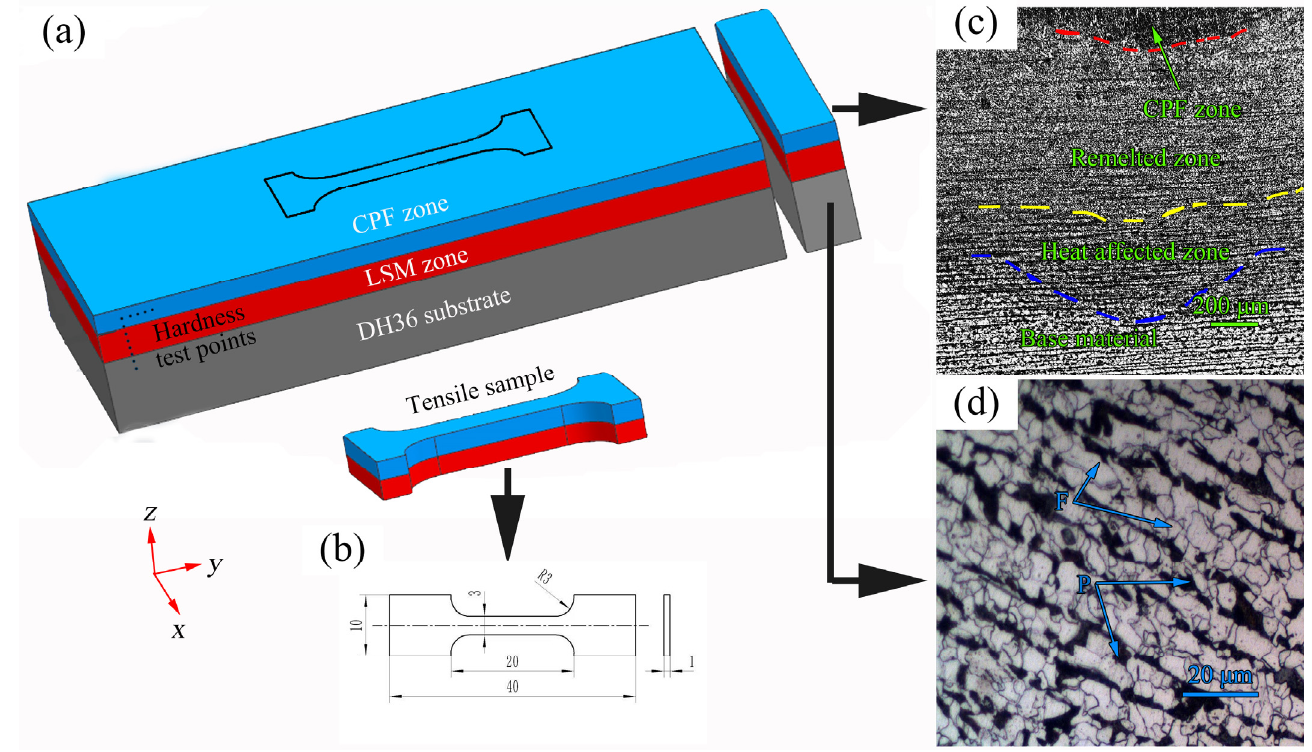
Figure 2. ( a ) Schematic of LSM-CPF treated part and its mechanical tests approach; ( b ) geometric size of tensile test samples (unit: mm); ( c ) macrostructure of cross section of sample 3 manufactured by LSM-CPF and ( d ) microstructure of the DH36 substrate.